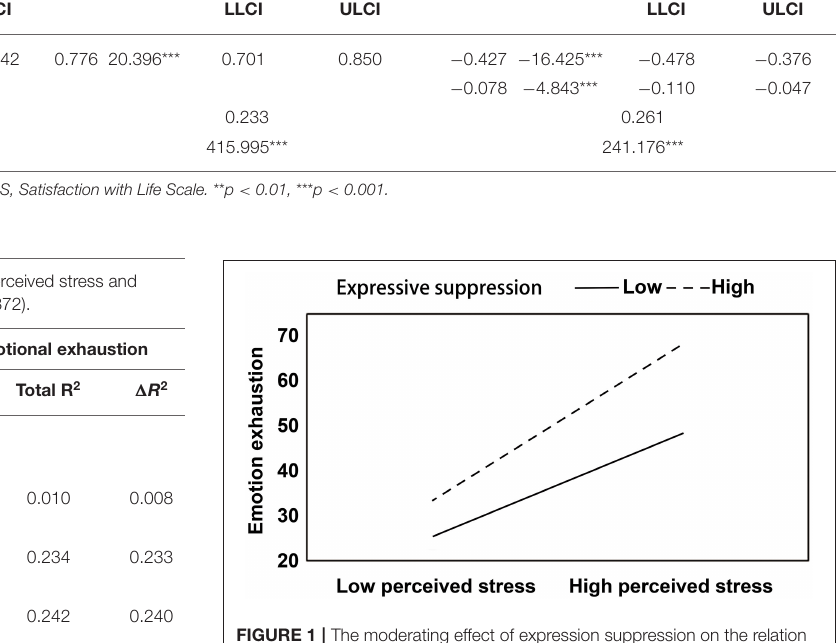
FIGURE 1 | The moderating effect of expression suppression on the relation between perceived stress and emotional